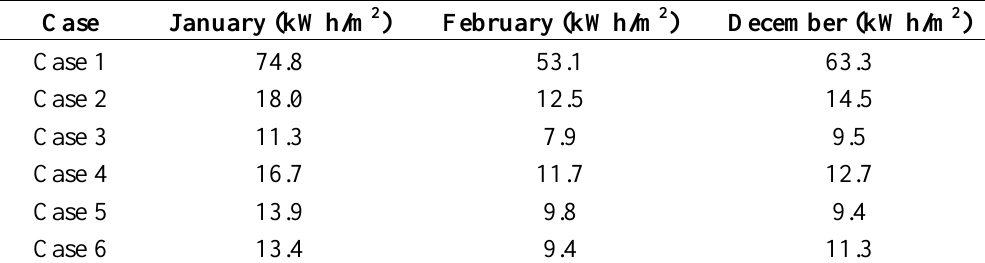
Table 8. Monthly total boiler gas and heat pump electricity